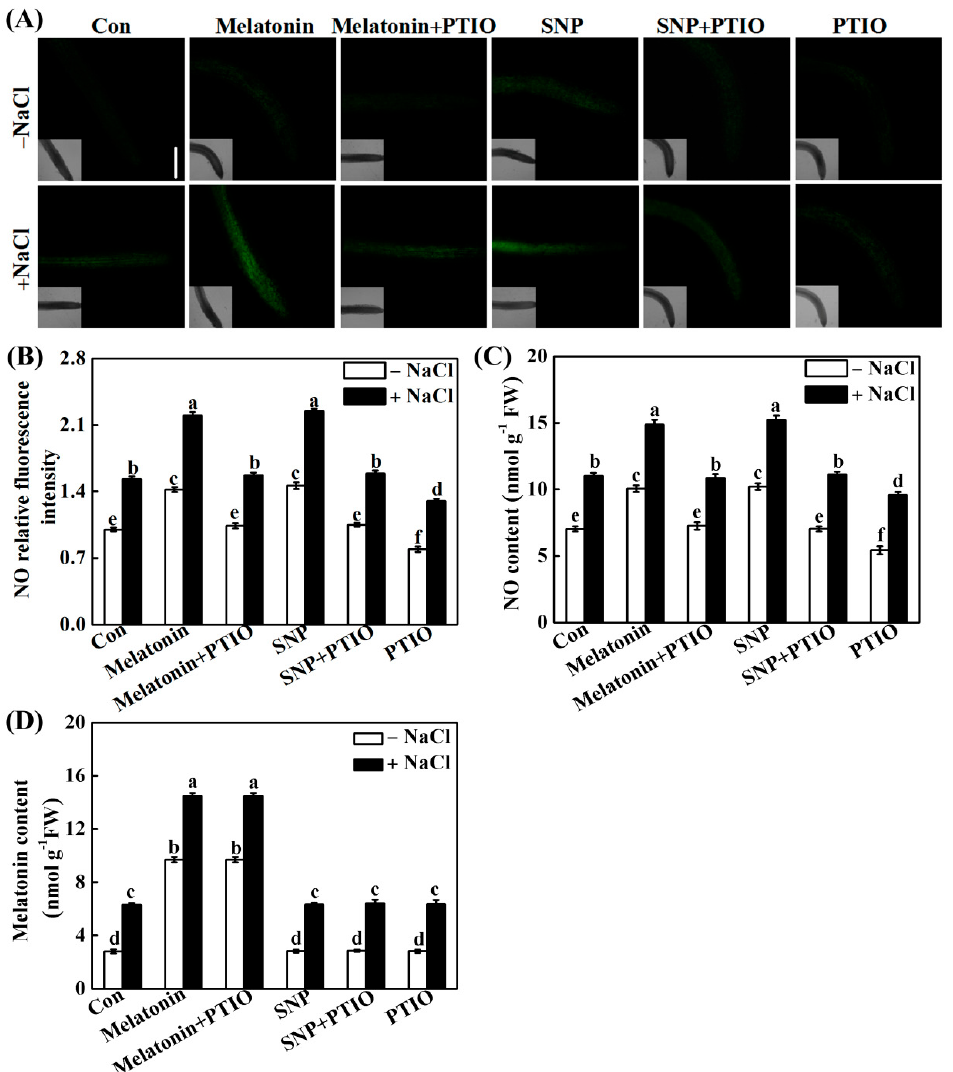
Figure 5. The removal of NO did not alter endogenous melatonin level, but melatonin triggered NO production. Three-day-old rapeseed seedlings were pretreated with 1 μ M melatonin, 10 μ M SNP, 200 μ M PTIO, alone or their combinations for 12 h, and then transferred to 200 mM NaCl for another 2 days. Afterwards, NO (( A ); determined by laser confocal scanning microscopy; ( C ); determined by visible spectrophotography) and melatonin contents (( D ); detected by enzyme-linked immunosorbent assay) in root tissues were detected. Scale bar = 1 mm. DAF-FM DA fluorescence densities according to ( A ) were also given ( B ). The sample without chemicals was the control (Con). Values are means ± SE of three independent experiments with at least three replicates for each. Bars with different letters are significant different at p < 0.05 according to Duncan’s multiple range